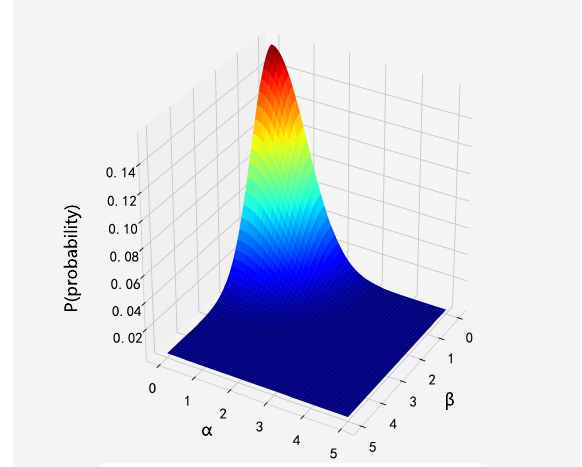
Figure 6. Parameter search space for the normal priors’